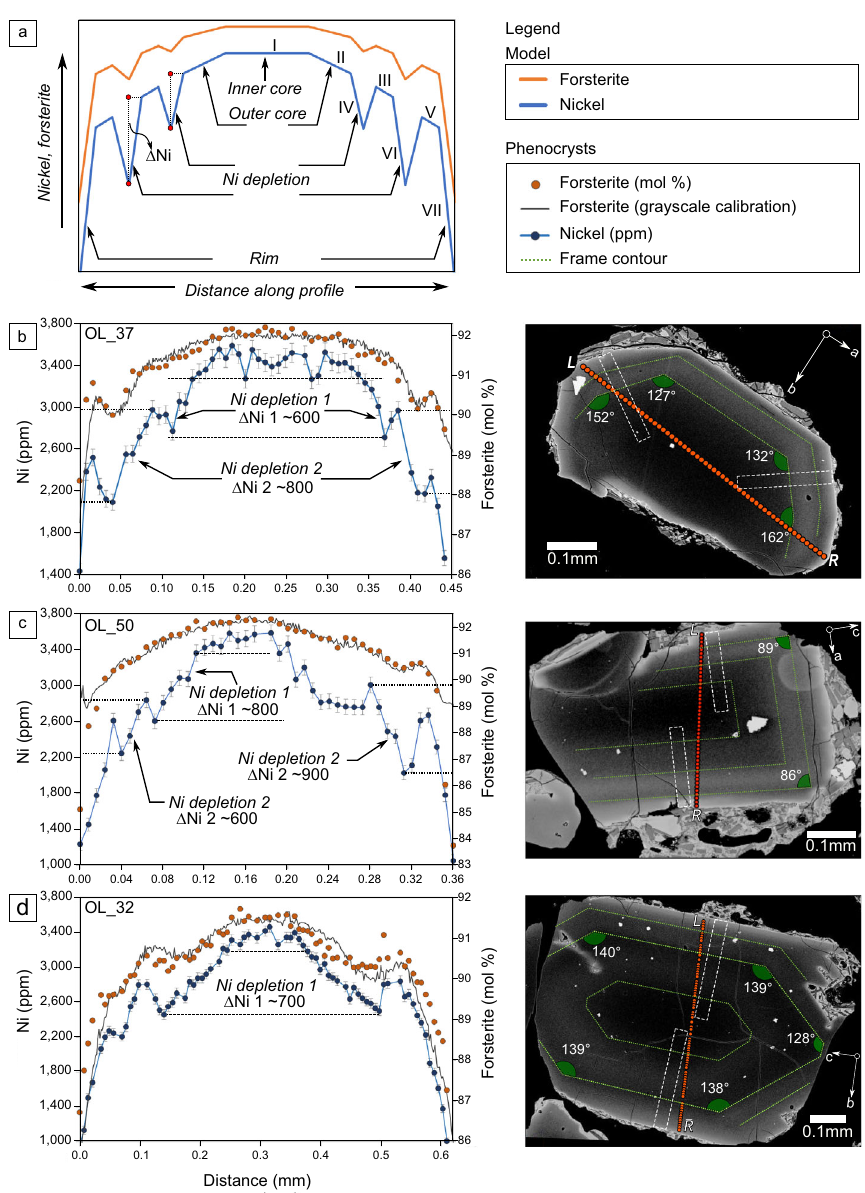
Fig. 2 A conceptual interpretation of major (Fo content) and minor (Ni) element zoning preserved in olivine phenocrysts (group 1 and 2) from Los Hornitos. a Schematic model of the Fo and Ni variations explained by four main zoning structures consisting of an inner and outer core, Ni depletions and rim. Roman numerals refer to the growth sequence of the crystal. b – d Fo (orange; right axis) and Ni (blue; left axis) contents along rim-to-rim traverses along three mature olivines sectioned normal to c, b, and a axis, respectively, with their BSE images and the analyzed traverses. Error bars on Ni data represent 1 sigma. Similar magnitudes of Ni depletions ( Δ Ni) are observed among the crystals. Segmented green lines above the images enhance the position of chemical reversals, which reproduce the euhedral olivine morphology, allowing the crystal to be oriented (see raw images and orientation parameters in Supplementary Information Fig. S6). White segmented blocks show the location of diffusion pro fi les for timescale calculations. Olivine composition data can be found in Supplementary Data